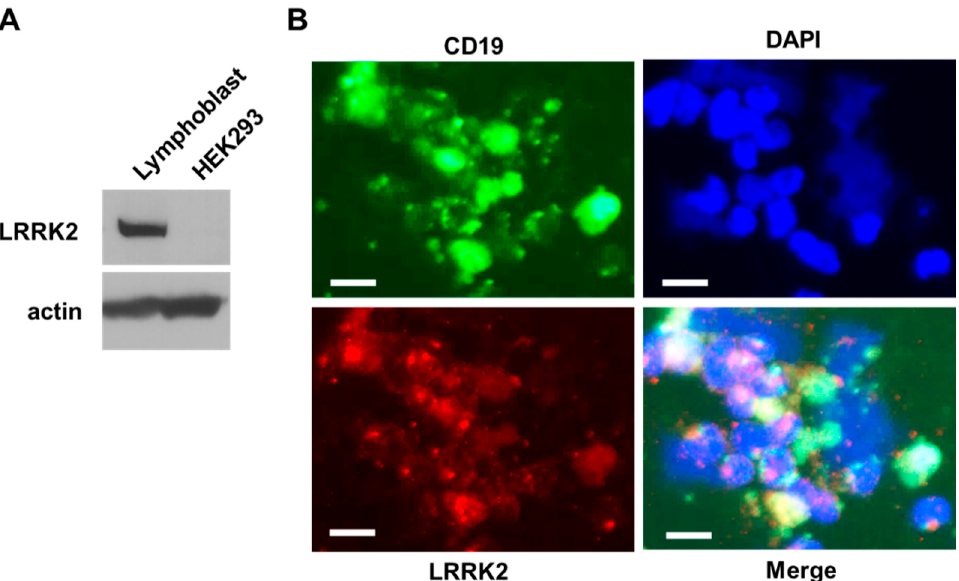
Figure 1. Leucine-rich repeat kinase-2 (LRRK2) is expressed in human lymphoblasts. ( A ) Cell lysates from human lymphoblasts and HEK293T cells were subjected to immunoblot analysis using anti-LRRK2 (top) antibodies. Equal protein input was controlled by a Western blot using anti-actin (bottom). ( B ) Representative co-immunostained images of human lymphoblasts are shown using anti-CD19 (B-cell marker, green) and anti-LRRK2 (red) antibodies. DAPI was used to label nuclei. The white scale bar indicates 10 microns.